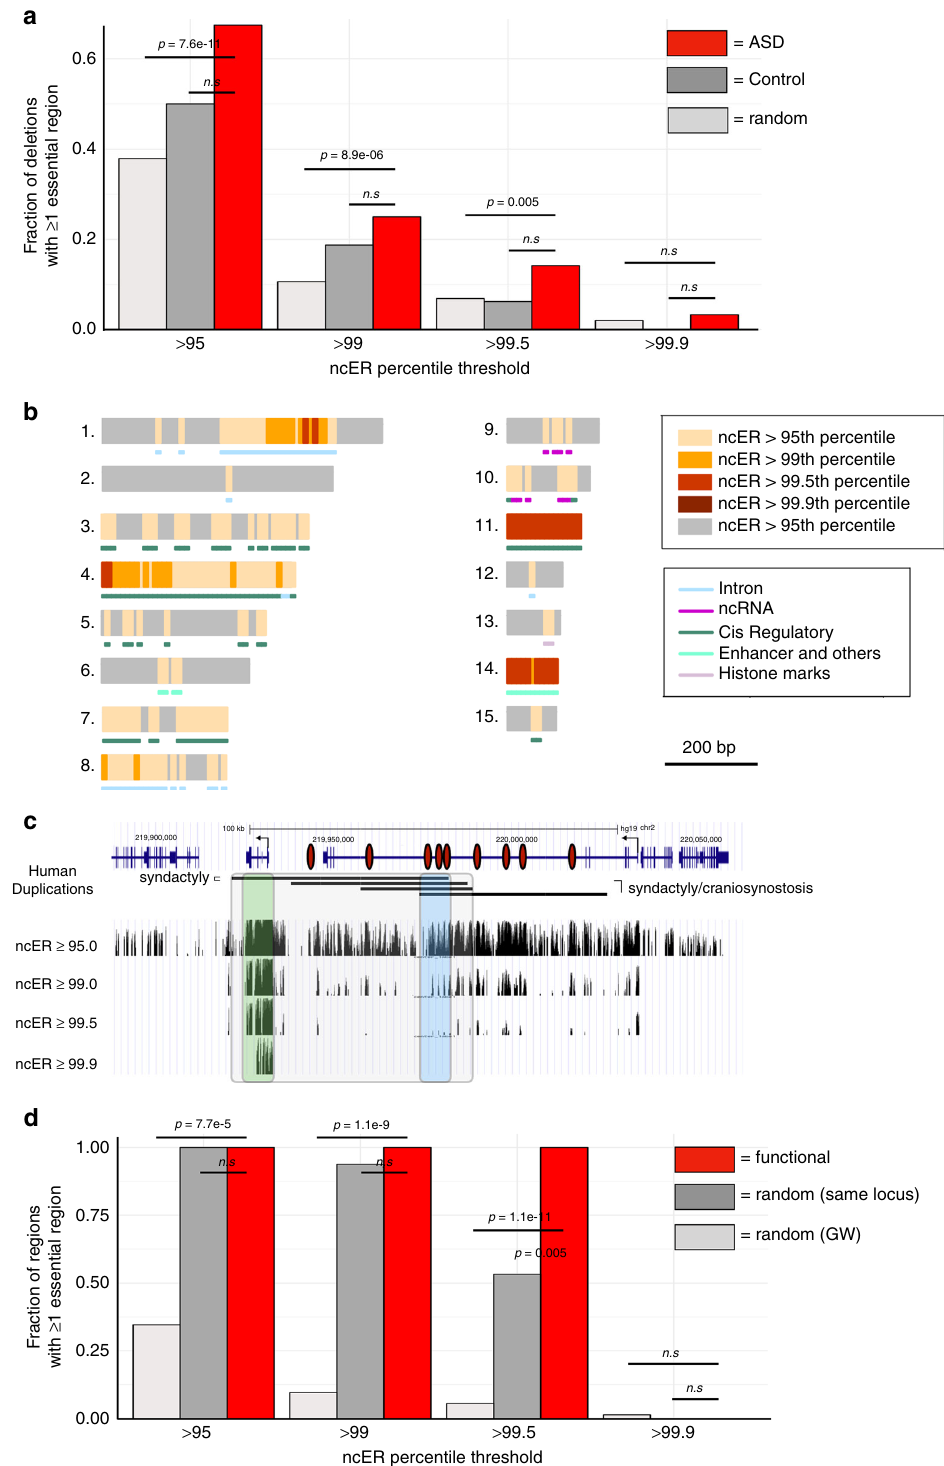
Those included (i) median gene expression and variance across tissues (GTEx) 49 , (ii) functionally tested genomic regions with enhancer activity identi fi ed through (ChIP-)STARR-seq experiments 27,50 or validated with transgenic mice 51 and (iii) lncRNAs identi fi ed through CAGE and transcriptome analysis 52 . Lastly, variant pathogenicity/deleteriousness scores used in the model included CADD 14 , ncEigen 15 , FATHMM 18 , FunSeq2 17 , LINSIGHT 22 , ncRVIS 31 , Orion 21 and ReMM 19 . We downloaded pre-computed genome-wide scores for each of these metrics (hg19 reference build). In the minority of cases where a per alternative variant score was provided, we used the most “ deleterious ” value at each position. For the metrics that solely provide scores for the genic portion of the genome,